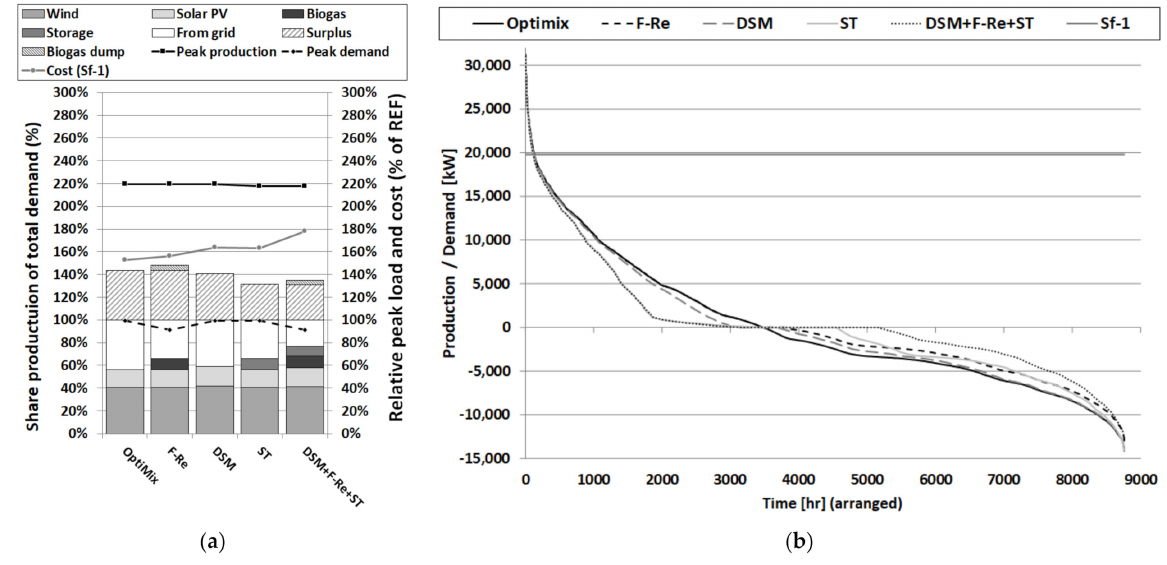
Figure 6. ( a ) Share of total demand per production for balancing technology scenarios, ( b ) Net load duration curves of the balancing technology scenarios. Table 12. Effects of curtailment on the renewable integration scenarios.